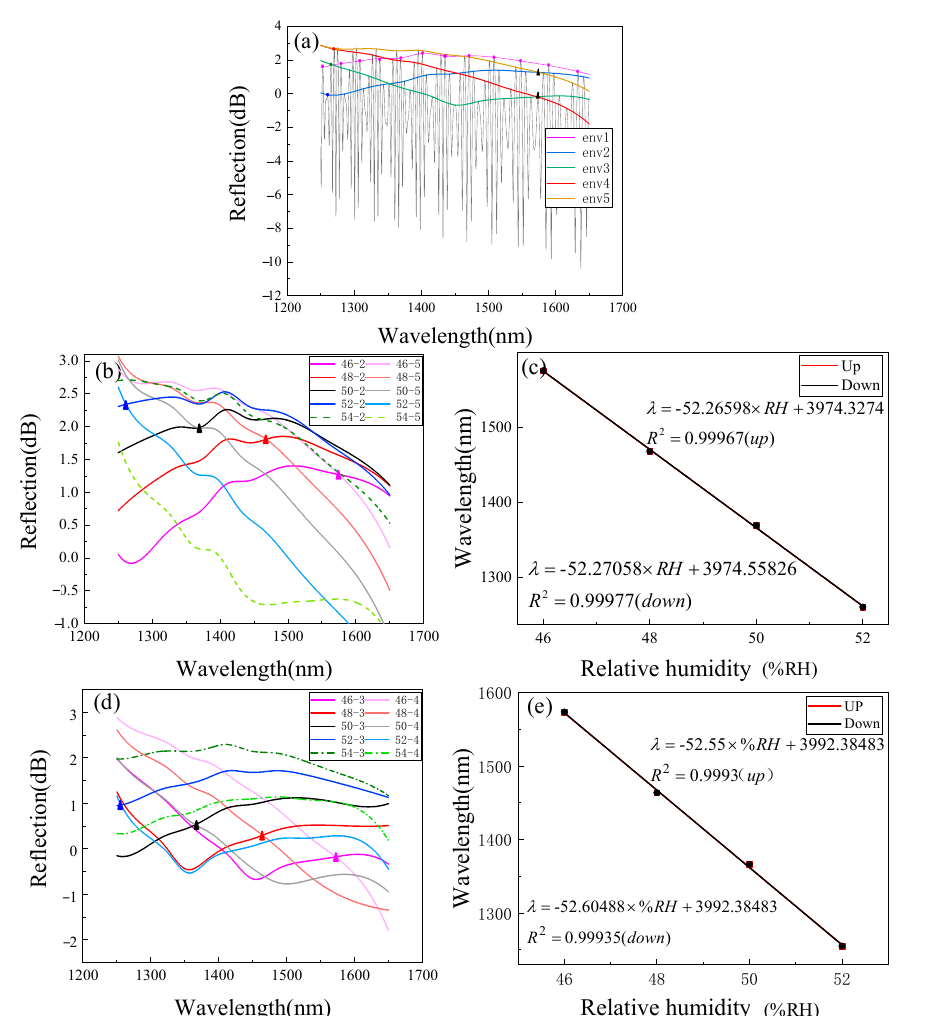
Figure 10. RH response results of inner envelope. ( a ) Spectra of the inner envelope fitting; ( b ) spectral changes of the intersection of env2 and env5; ( c ) the intersection of env2 and env5 has a linear relationship with RH; ( d ) spectral changes of the intersection of Env 3 and env 4; and ( e ) the intersection of env3 and env4 has a linear relationship with humidity.